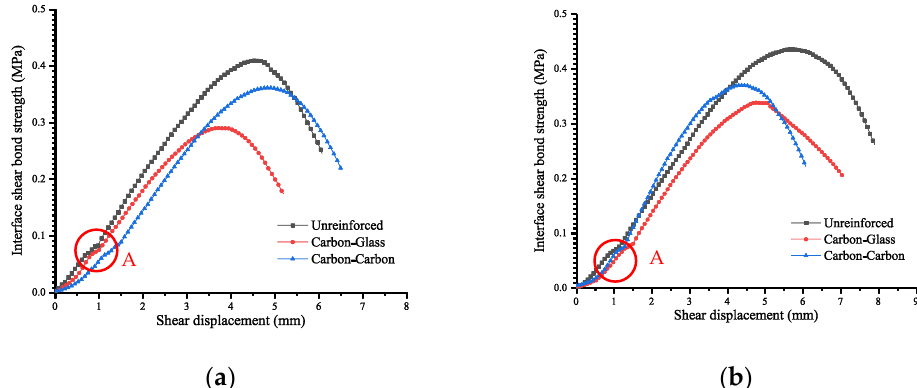
Figure 4. The results of the direct shear tests.